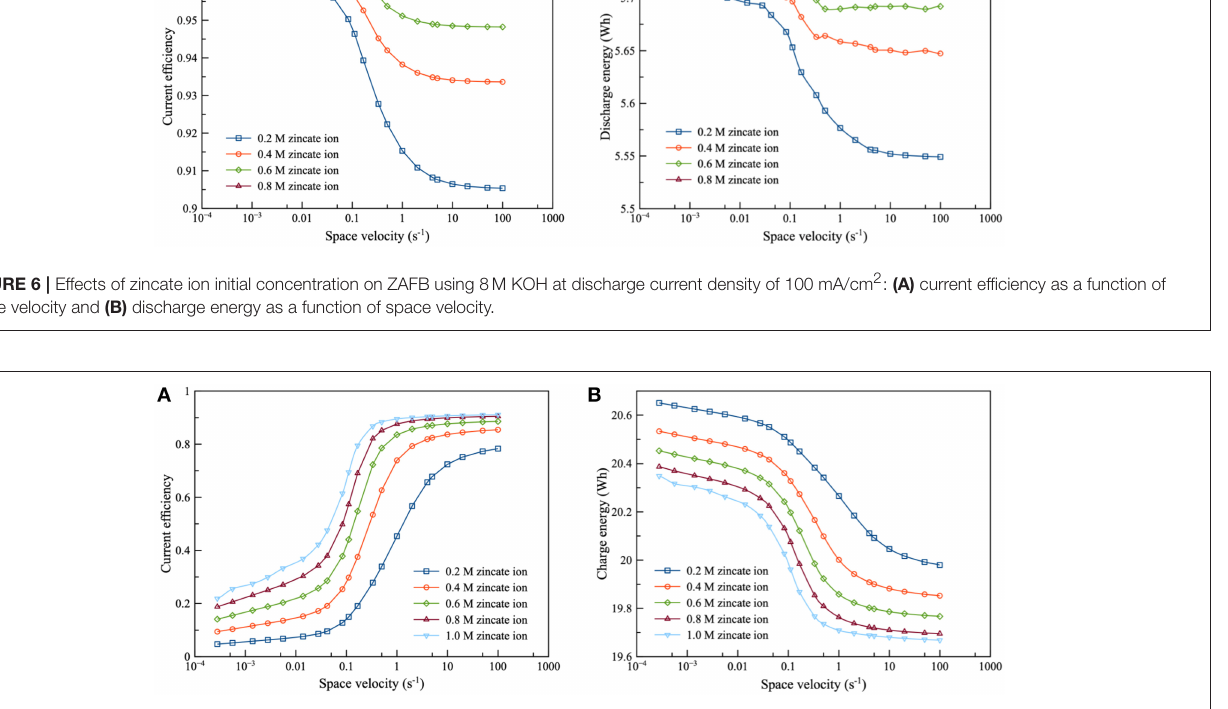
FIGURE 7 | Effects of zincate ion initial concentration on zinc electrolyzer using 8M KOH at charge current density of 100 mA/cm 2 : (A) current efficiency as a function of space velocity and (B) charge energy as a function of space velocity.